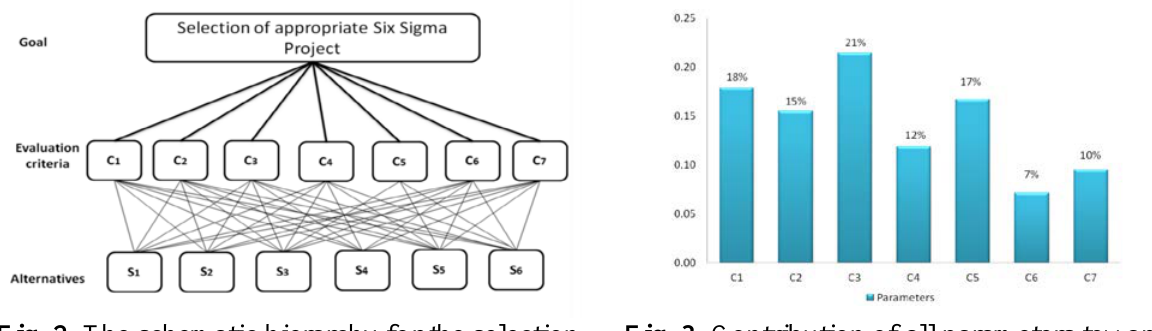
Fig. 3. Contribution of all parameters towards the selection of right Six Sigma